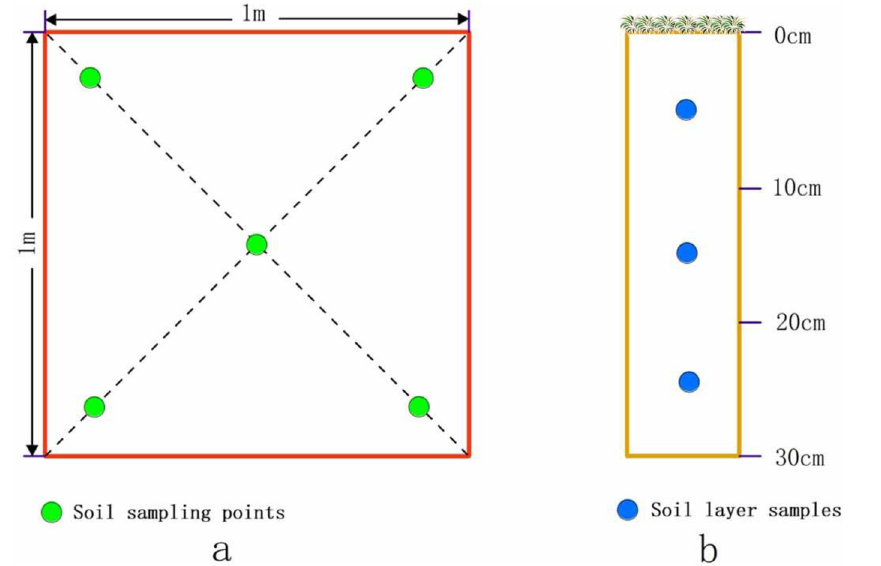
Fig 2. Schematic diagram of soil sampling (a: Layout of sample points; b: Sampling of soil profile). Sample plots were divided into five soil sampling points according to a diagonal layout (Fig 2a). Each soil sampling point included three soil layers (0–10 cm, 10–20 cm and 20–30 cm depth) (Fig 2b). Soil samples were transported back to the laboratory for air drying, removal of